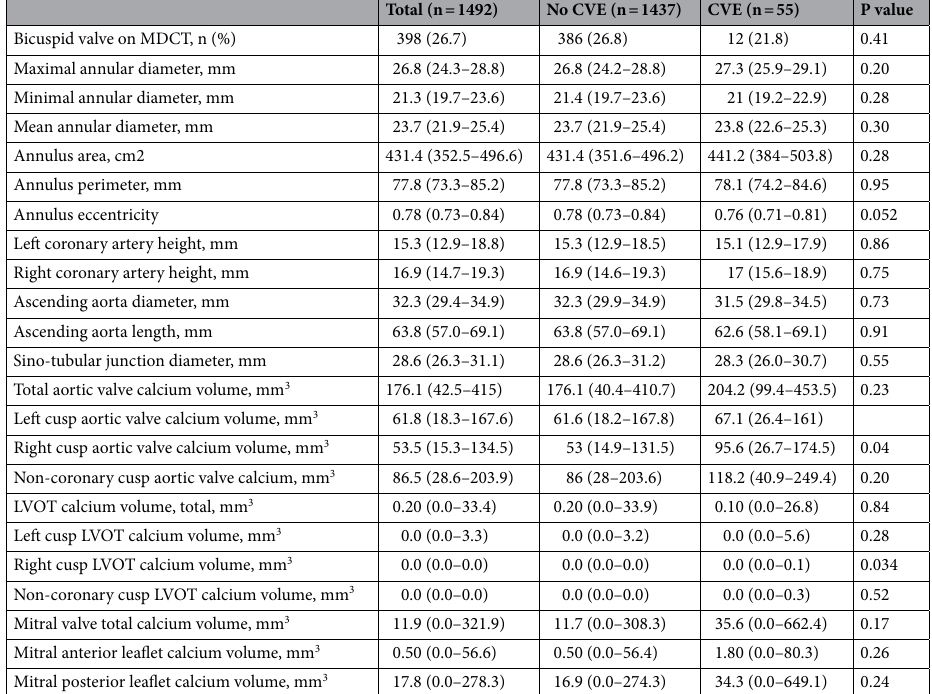
Table 2. Patient CT imaging characteristics. LVOT left ventricular outflow tract.